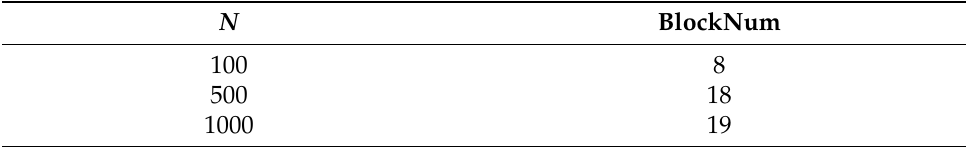
Table 1. The effect of changing N